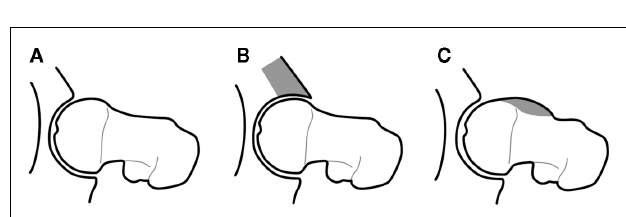
FIGURE 3 | Diagrammatic representation of the morphological variants implicated in FAI that lead to increased stress on articular cartilage, prompting premature breakdown of the normal joint homeostasis and early development of OA: (A) normal; (B) “pincer” deformity of the anterior acetabulum; (C) “cam” deformity of the anterior femoral head–neck junction, afterTannast et al. (2007) .